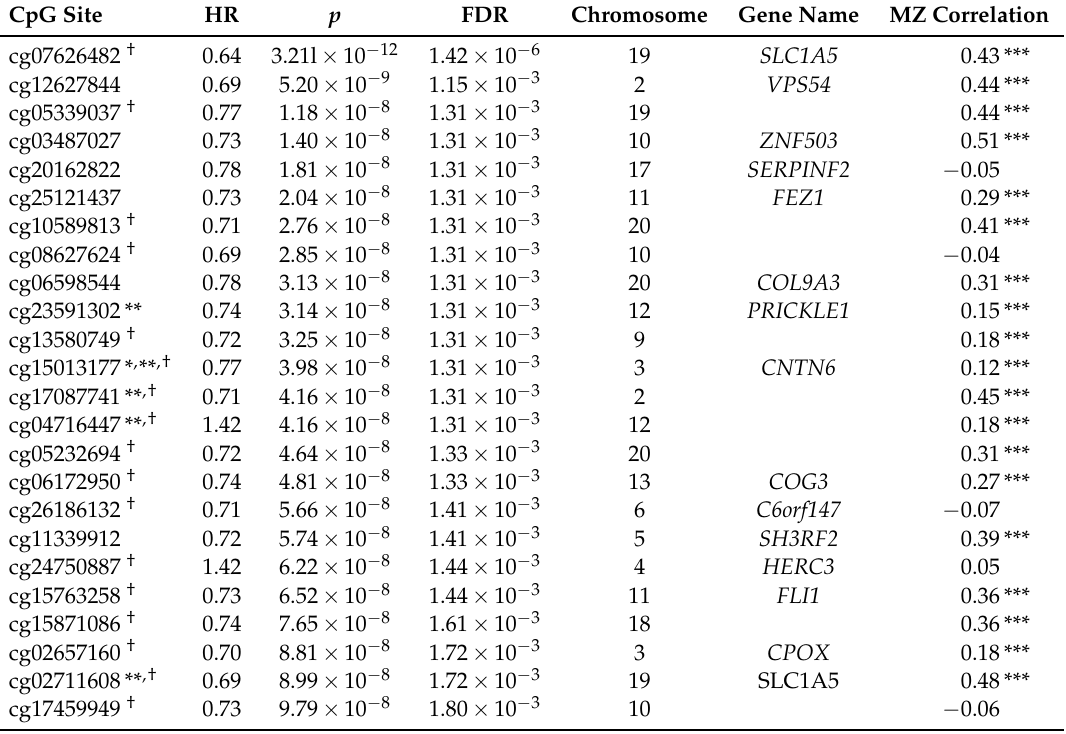
Table 2. The 24 CpG sites with p < 10 − 7 in the univariate